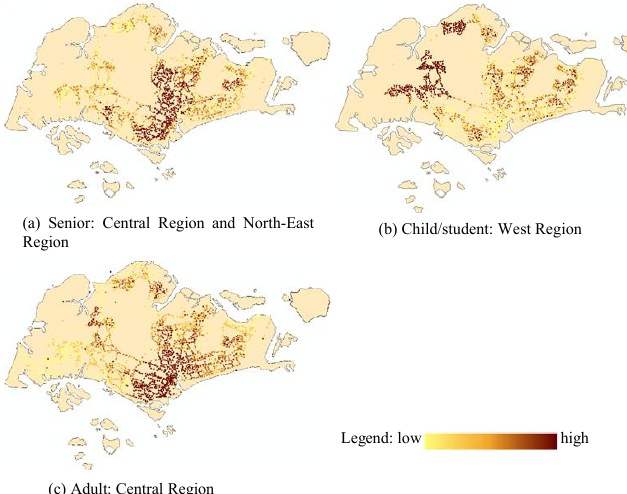
the three categories